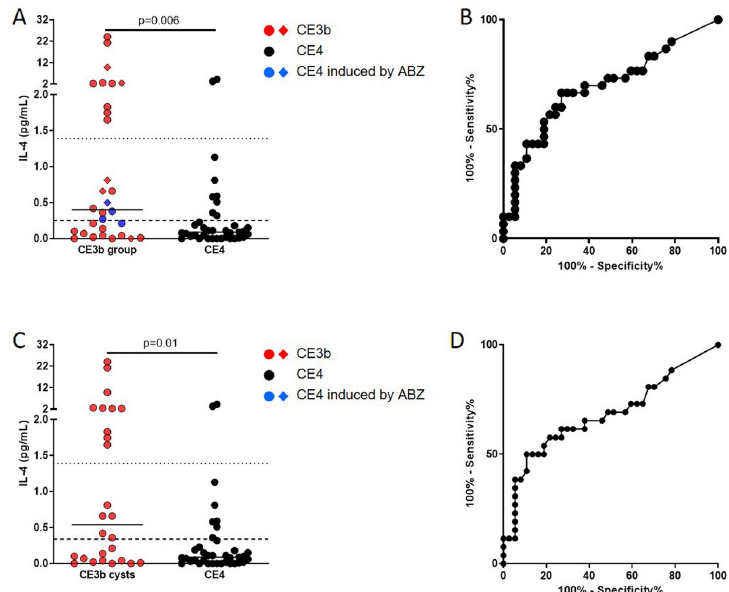
Fig 1. IL4-specific response is significantly associated to CE3b cysts. A. IL-4 levels are significantly increased in the CE3b-group compared to CE4-group. B. AUC analysis for CE3b-group diagnosis; the 0.25 pg/mL cut-off maximizing sensitivity for CE3b-group diagnosis (panel A, dashed line) showed a 60% sensitivity and 76% specificity whereas the 1.39 pg/mL cut-off to maximize specificity (panel A, dotted line) showed 33% sensitivity and 95% specificity. C. The IL-4 levels were significantly increased in patients with CE3b cysts compared to the CE4-group. D. AUC analysis for CE3b diagnosis; the cut-off of 0.34 pg/mL maximizing sensitivity for CE3b cysts (panel C, dashed line) predicted CE3b with a 57.7% sensitivity and 78.4% specificity; the cut-off of 1.39 pg/mL cut-off to maximize specificity (panel C, dotted line) predicted CE3b with 38.5% sensitivity and 95% specificity. Footnotes: Horizontal bars represent medians. IL-4 concentrations were determined by ELISA. Responses in panels A and C were compared using the Mann-Whitney test; ROC-analysis was applied in panels B and D; differences were considered significant at p-values of � 0.05. Red dots indicate patients with CE3b cysts, blue dots indicate patients with treatment-induced CE4 cysts, black dots indicate patients with spontaneously-inactivated cysts, diamond symbols indicate that the patient received albendazole. IL: Interleukin; CE: Cystic Echinococcosis; ABZ: